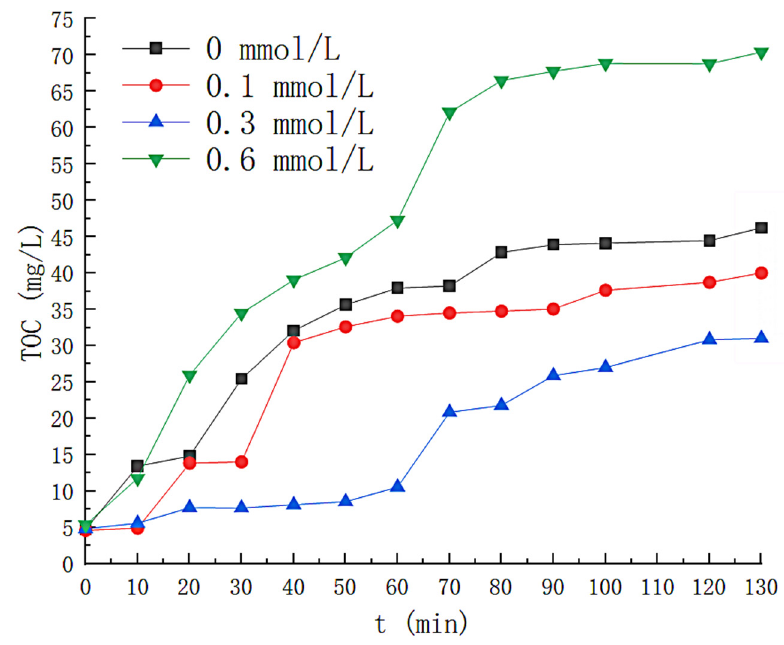
Figure 8. Effect of Fe 2+ concentration on TOC concentration.